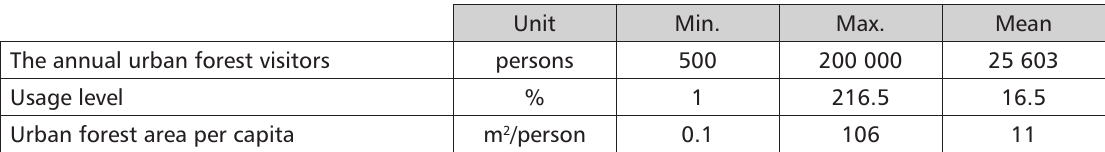
Information about urban forest recreation services